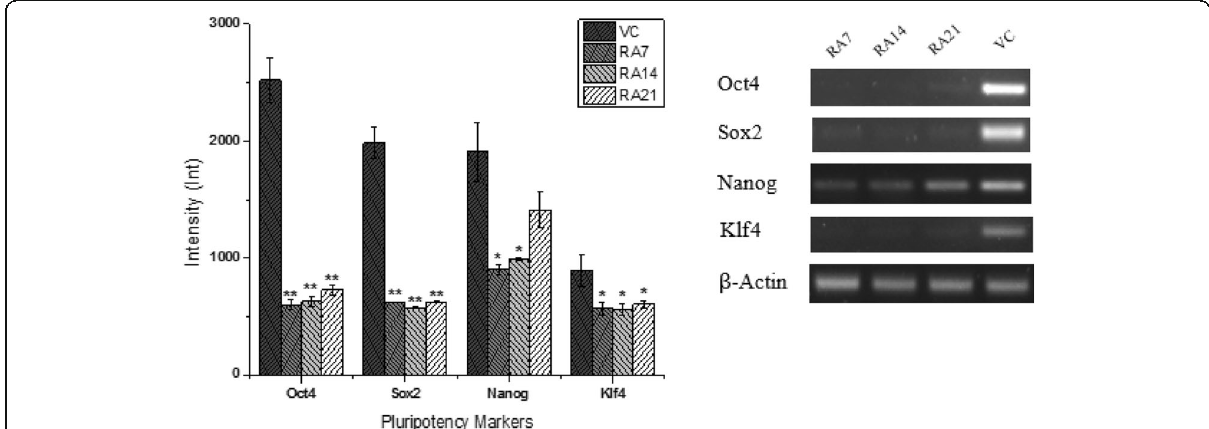
Fig. 9 RT-PCR analysis of stem cell genes in NT2 cells at different time points (7, 14, and 21 days) after treatment with retinoic acid (RA). Representative agarose gel electrophoresis patterns of RT-PCR products showed reduced expression of Oct4, Sox2, Nanog, and Klf4. All gene expression data were normalized to β -actin as an internal control. Band intensity was measured and the values were expressed as the mean ± SD of two independent experiments. * P < 0.05, ** P < 0.01 compared to vehicle control (VC; 0.001%